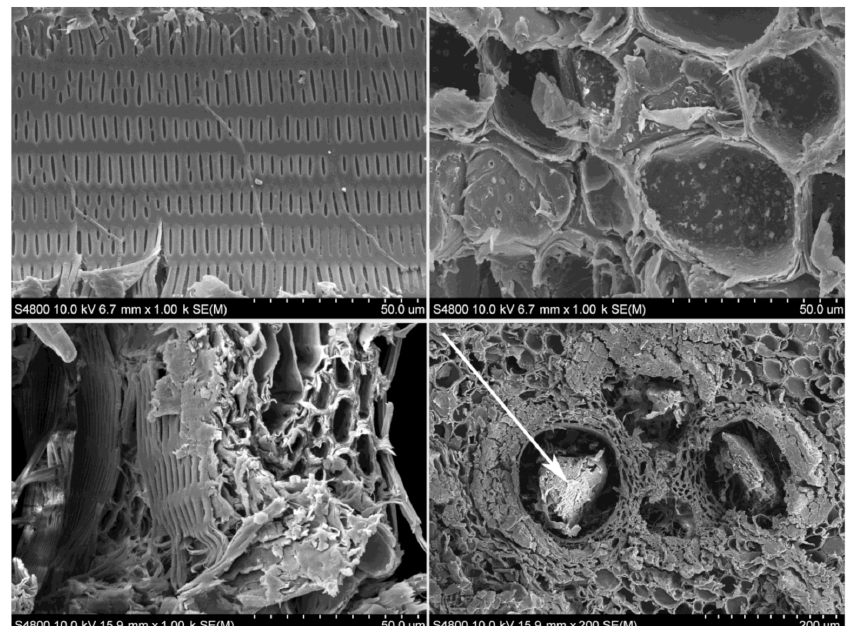
Figure 8. SEM images of ( a ) longitudinal cut of AA, detail of vessel, ( b ) parenchyma cells of AA, ( c ) detail of vessels and cells of AA and ( d ) obstructed vessels of